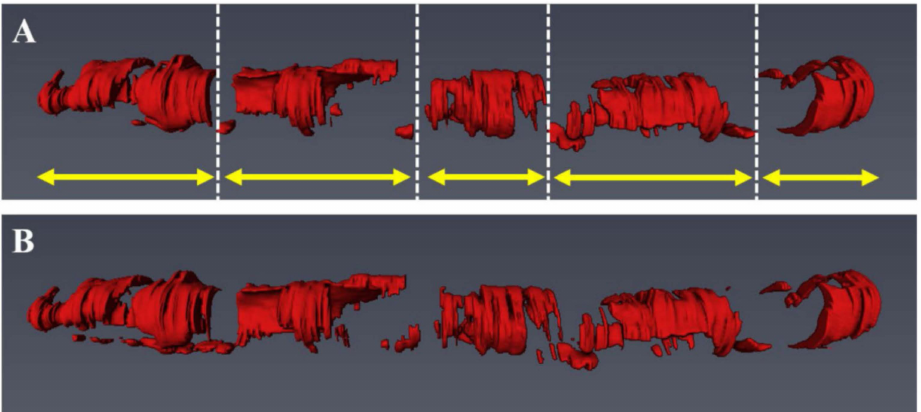
Figure 10. Visualization of the five major calcified lesions (yellow arrows) after 3D reconstruction and comparison between the manually annotated ground truth ( A ) and the automated method ( B ). Reprinted from [169], with permission, under the Creative